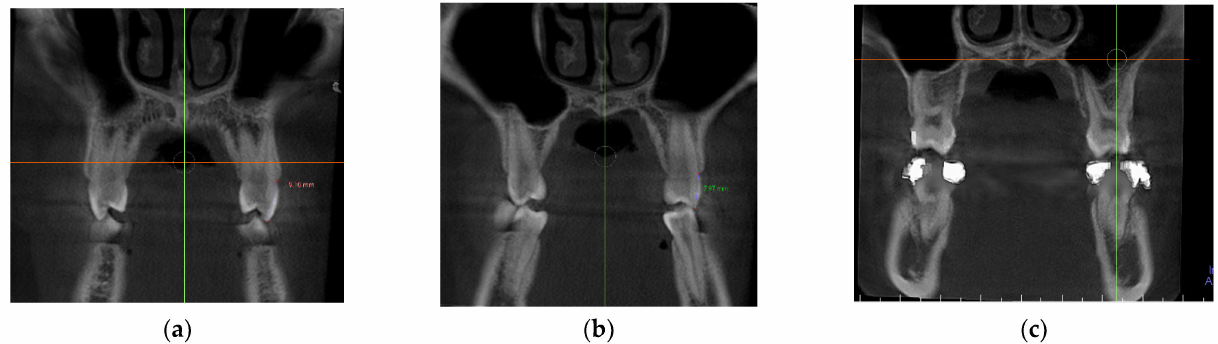
Figure 2. Selected cut-off points in the coronal plane at: ( a ) first premolar, ( b ) second premolar and ( c ) first molar.